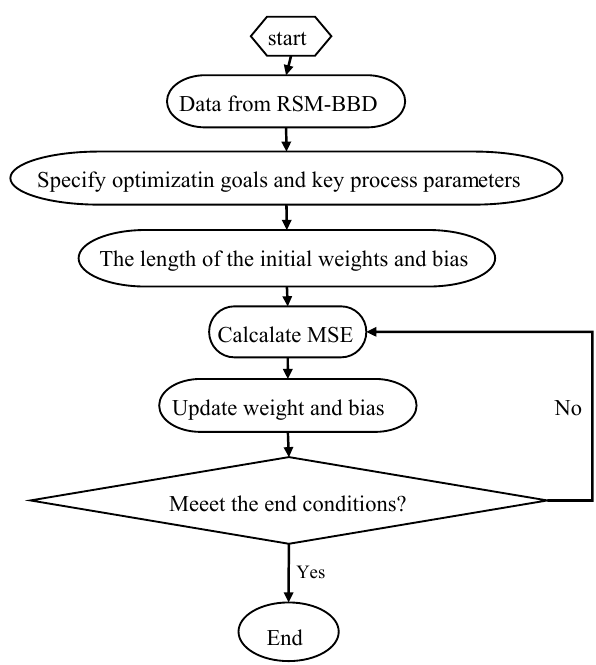
Figure 1. Flow diagram of neural network (ANN) training.